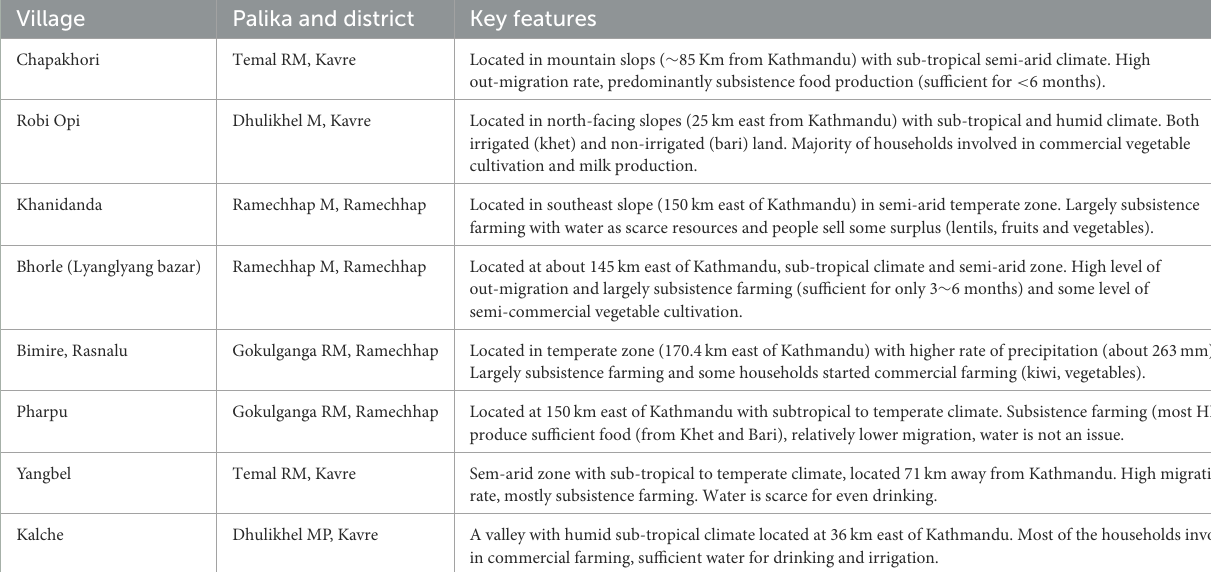
TABLE 2 Description of the survey